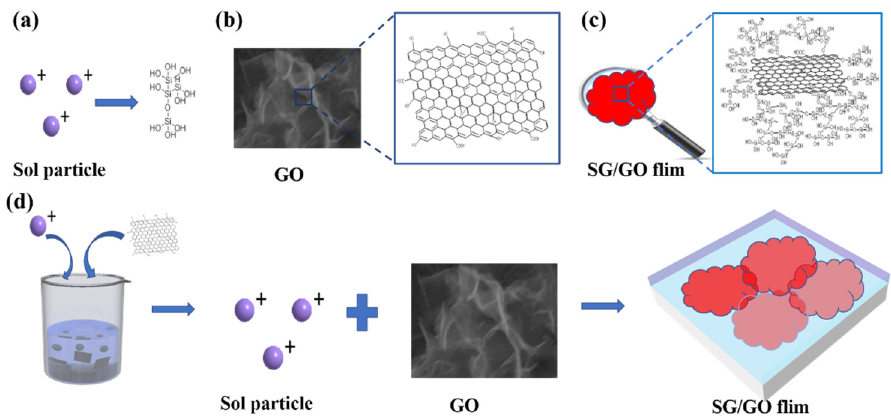
Table 1. Composition of AA5052 (mass fraction, %)